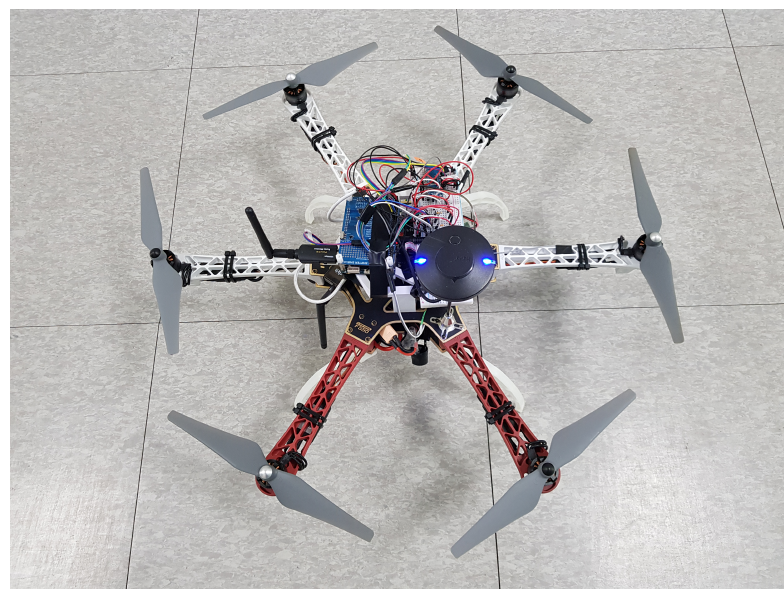
Figure 8. Prototype implementation of the system.